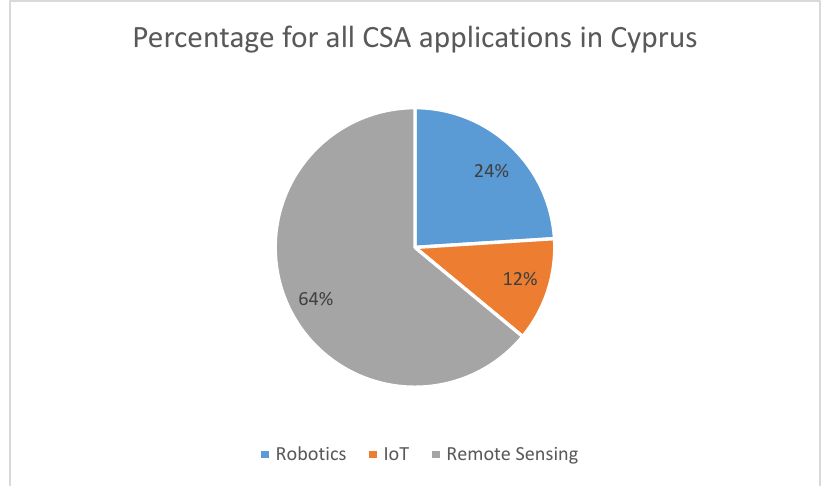
Figure 3. Percentages of publications on robotics, IoT, and remote sensing during 2010 – 2020 (results referring to Cyprus Climate-smart agriculture applications).